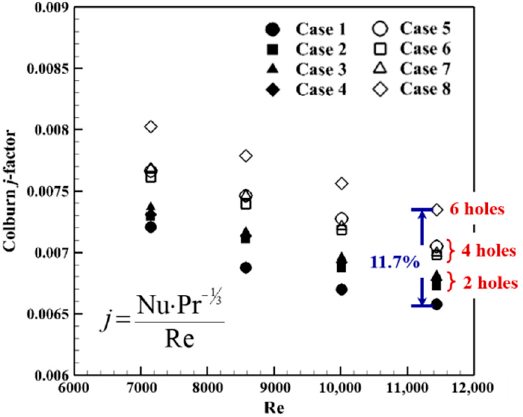
Figure 10. Colburn j ‐ factor with the Reynolds number.